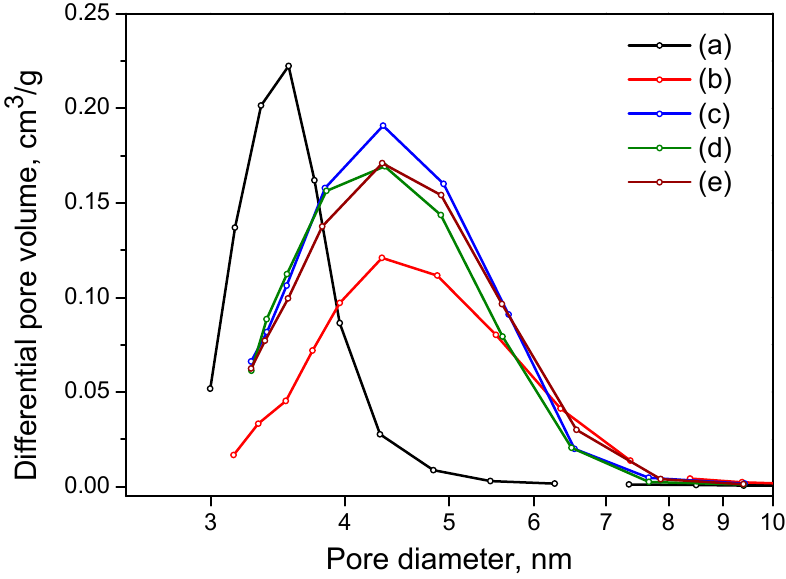
Figure 8. Pore size distribution curves for fresh Al 2 O 3 samples prepared at various pH values: (a) Al-5; (b) Al-6; (c) Al-7; (d) Al-8 and (e) Al-9.